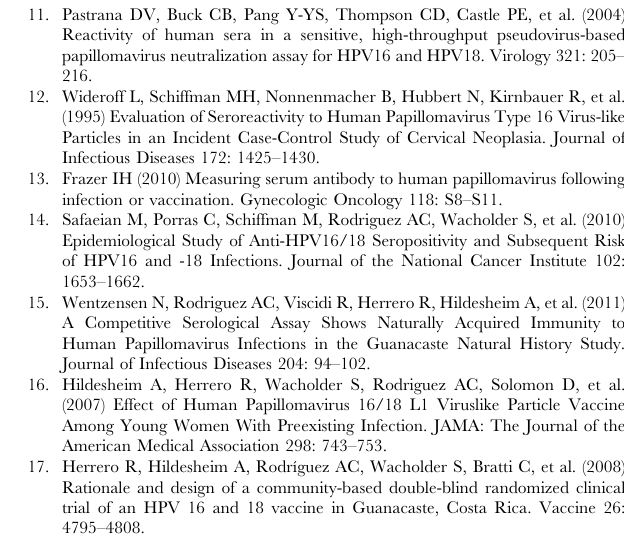
Table S1 Risk of HPV16 DNA infection in strata of enrollment HPV16 ELISA, cLIA, and SEAP-NA serology